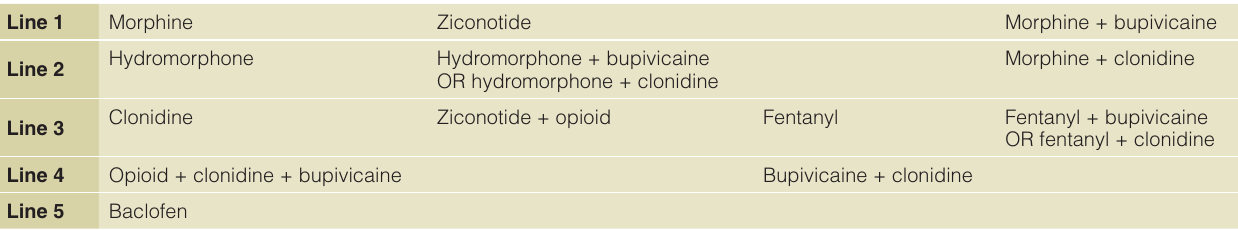
Table 3. 2012 polyanalgesic algorithm for intrathecal (IT) therapies in neuropathic pain 7 .